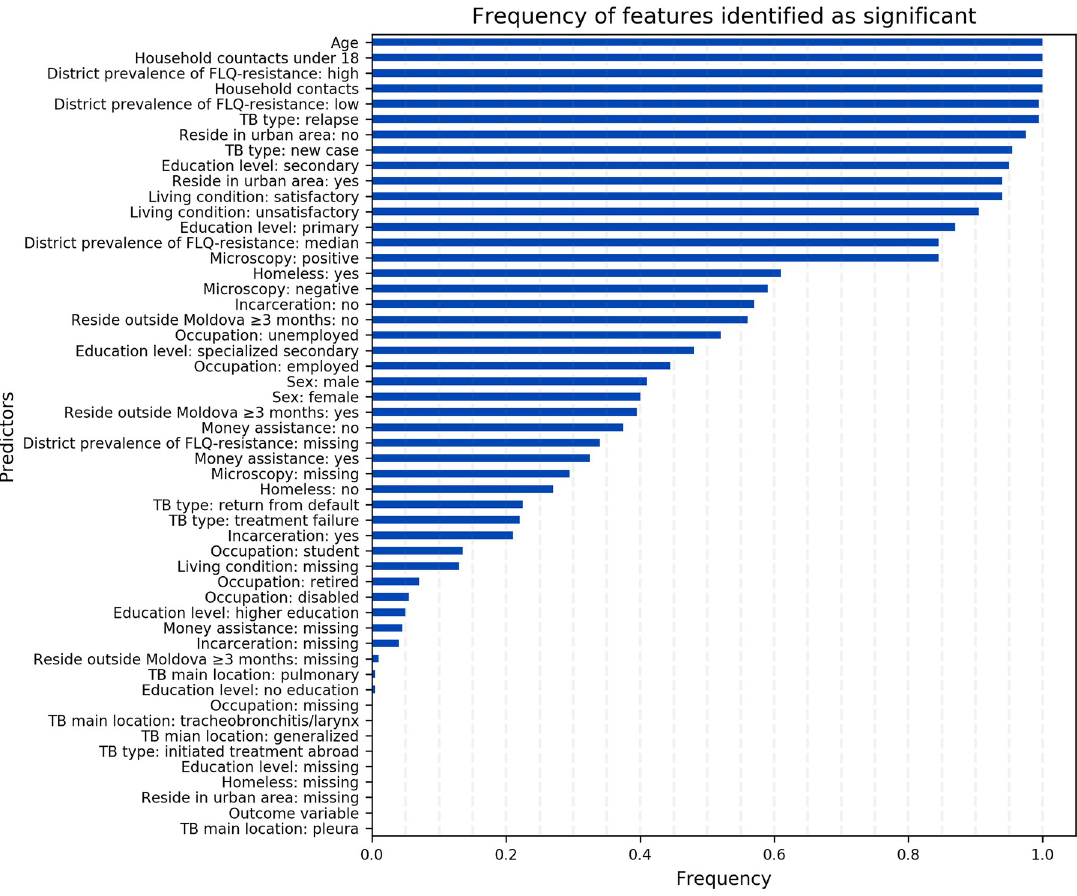
Fig 2. The frequency of features identified as important through iterations of the bootstrap validation algorithm (§S4 in S1 Text) to evaluate the OC-AUC-ROC of our final model (neural network classifier and permutation importance algorithm).